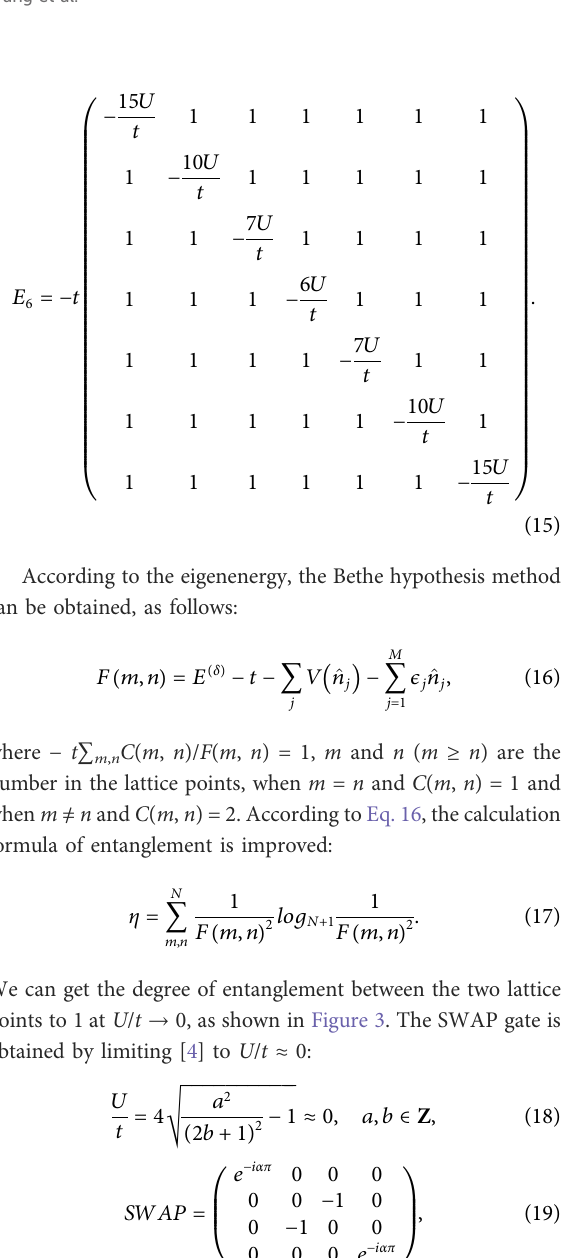
state, and | n 〉 is the position state. In the process of quantum walk, there are mainly two kinds of errors, which are phase inversion and bit inversion. However, the amplitude in Eq. 23 is generated by the superposition state, so the detection and correction of walker errors are mainly aimed at bit inversion errors. The quantum walk error correction circuit is shown in Figure 4. In order to suppress the error generated in the quantum walk, the noise error based on the double-lattice Bose – Hubbard model in the quantum walk is reduced by reducing the circuit gate overhead. Taking depolarization noise as an example, the data map is obtained through the training of the decoder. The decoder uses the convolutional neural network [27 – 29] in the current hot machine learning algorithm as the dominant algorithm to decode the quantum information in the line. The speci fi c decoding training model is shown in Figure 5. By training with different restnet layers, the accuracy and speed of training are improved; the speed is 1/3 higher than before and the accuracy reaches